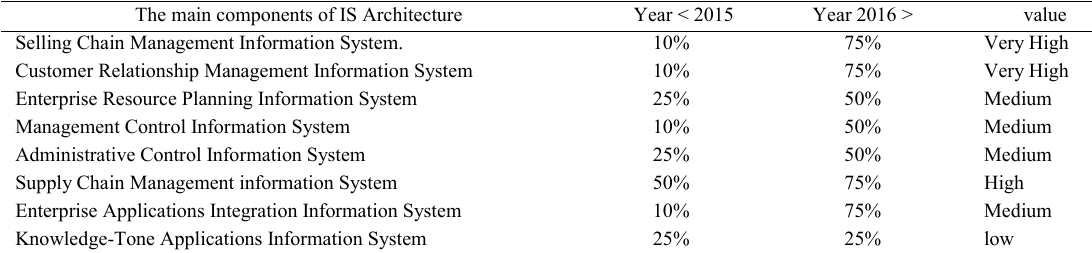
TABLE 2 E STIMATES R ISK PROBABILITIES IN A FIRM ' S